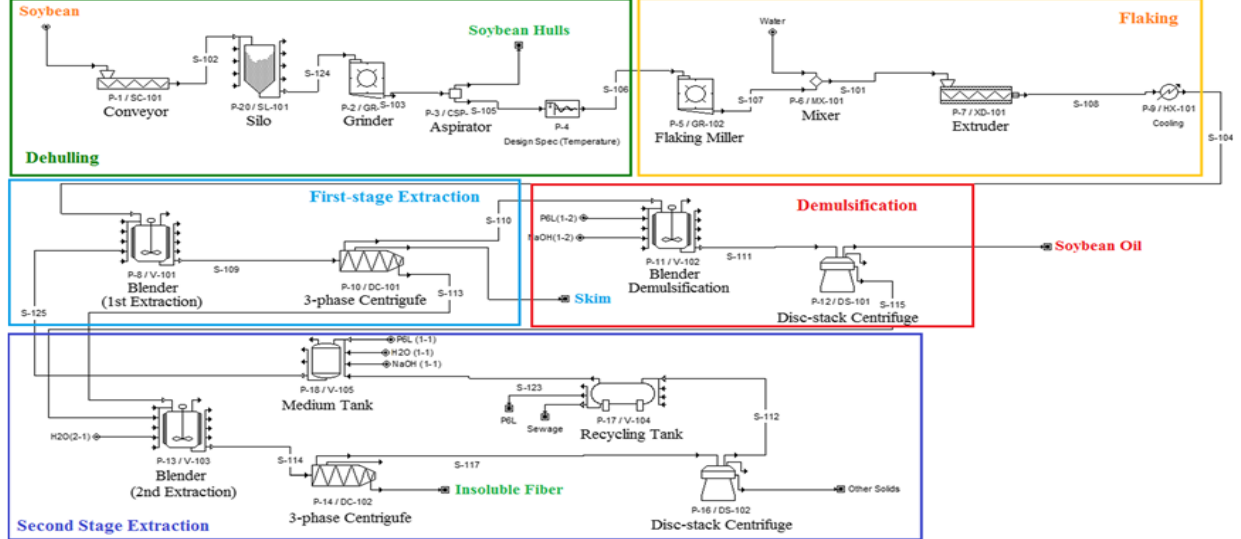
Figure 17. Process scheme for recovering jet fuel from emulsions [198]. Reproduced from Hernando Salgado, et al., 2014 (ref. [198]).